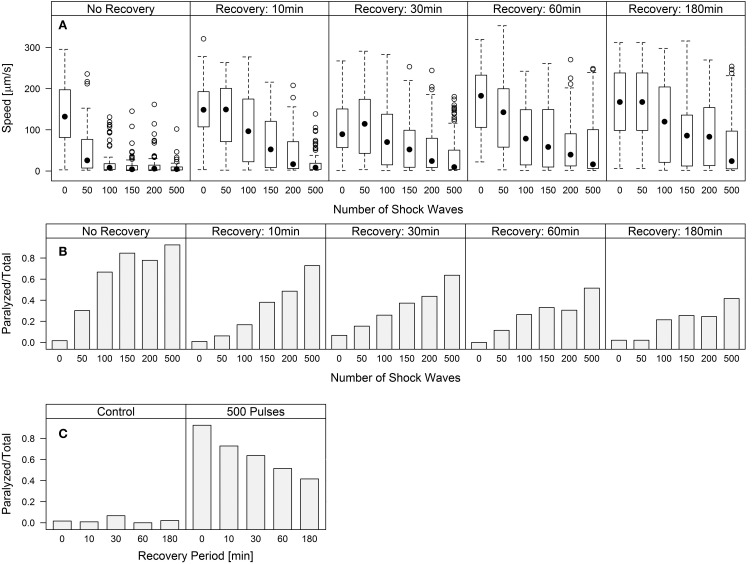
C. elegans regain behavioral function following the application of shock waves. (A) Increased shock wave exposure reduced average worm speed (p < 0.001), while increased recovery period of up to 180 min resulted in increased speed (p < 0.001) (B) Fraction of worms paralyzed decreased over a 180 min recovery period. Regaining of function was observed in all groups after only 10 min, while control worms exhibited no noticeable difference between groups. (C) Worms exposed to 500 shock waves demonstrated gradually increasing recovery over four time points up to 180 min.